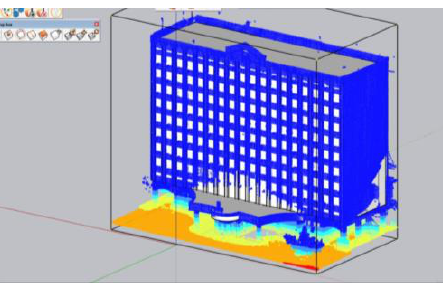
Figure 11. Display functions. Undet for SketchUp has powerful point cloud data